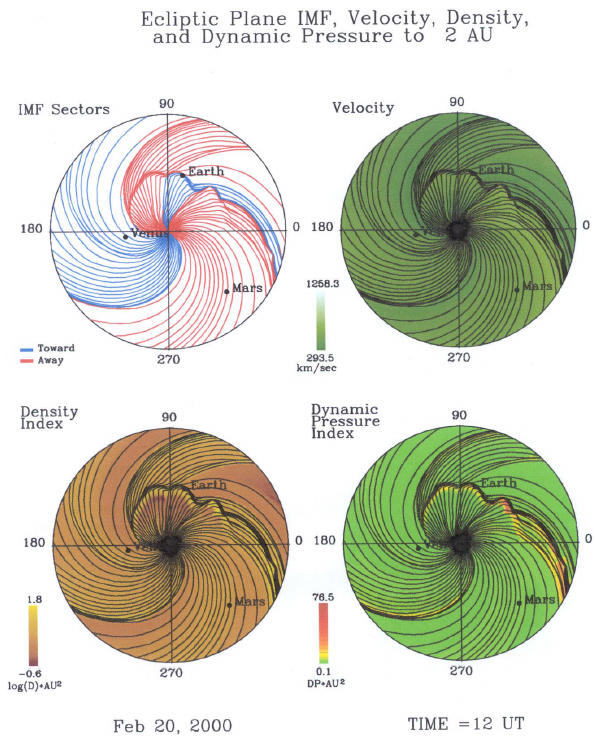
Fig. 4. Ecliptic plane simulation of the IMF by the HAFv.2 model Figure 4. Ecliptic plane simulations on the IMF by the HAFv.2 model, showing the showing the coalesced shocks from Events 4 and 5 at the time of im- coalesced shocks from Events 4 and 5 at the time of impact with Earth. Upper left: IMF pact with Earth. Upper left: IMF distortions at shock arrival on 20 distortions at shock arrival on 20 February 2000. Upper right: spatial profile of solar wind velocity. Lower right: spatial profile of solar wind dynamic pressure. The latter two February 2000. Upper right: spatial profile of solar wind velocity. physical parameters are normalized by (AU) 2 , as shown by the color bars. Lower left: spatial profile of solar wind density. Lower right: spa- tial profile of solar wind dynamic pressure. The latter two physical parameters are normalized by (AU) 2 , as shown by the color